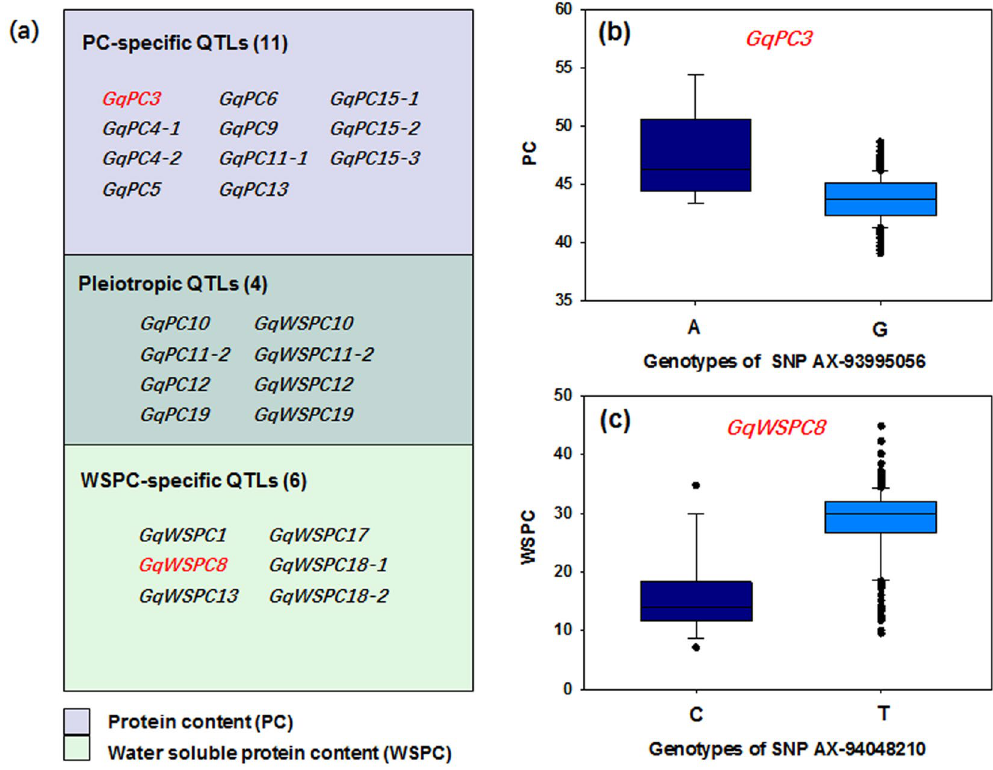
Figure 6. The genetic overlap between protein content (PC) and water-soluble protein content (WSPC) in the GWAS population. ( a ) Quantitative trait locus (QTL) categories and their number. ( b ) Associations between genotypes of SNP AX-93995056 and PC. Box plot of PC in 14 A-type and 195 G-type soybean accessions. The vertical axis indicates the PC. The PC of A-type accessions was significantly higher than that of G-type accessions ( t test, P = 3.17 × 10 − 8 ). ( c ) Associations between genotypes of SNP AX-94048210 and WSPC. Box plot of PC in 50 A-type and 169 G-type soybean accessions. The vertical axis indicates the WSPC. The WSPC of G-type accessions was significantly higher than that of A-type accessions ( t test, P = 1.01 × 10 − 29